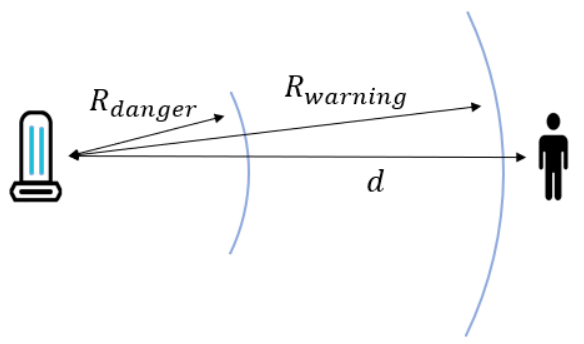
Figure 2. The dangerous radius of R danger and the warning radius of R warning of the UVD robot are set. The UVD robot detects a human and measures the distance of d